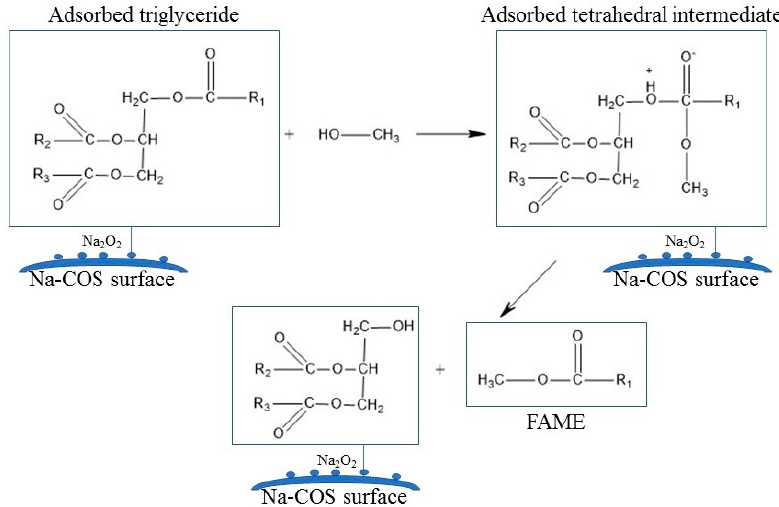
Figure 4. Role of Na-COS surface basic site on the improved activity. Energies 2017 , 10 , 1920